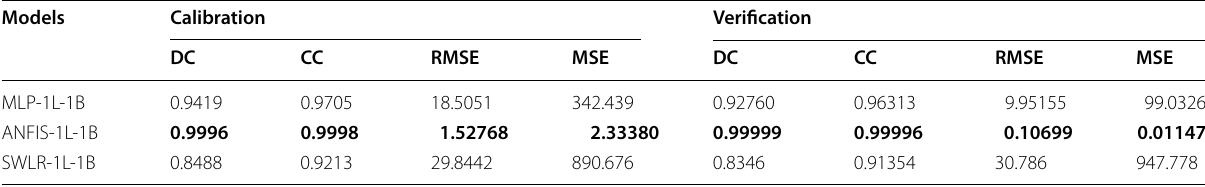
The best performing model are written in bold DC Determination co-effient, CC